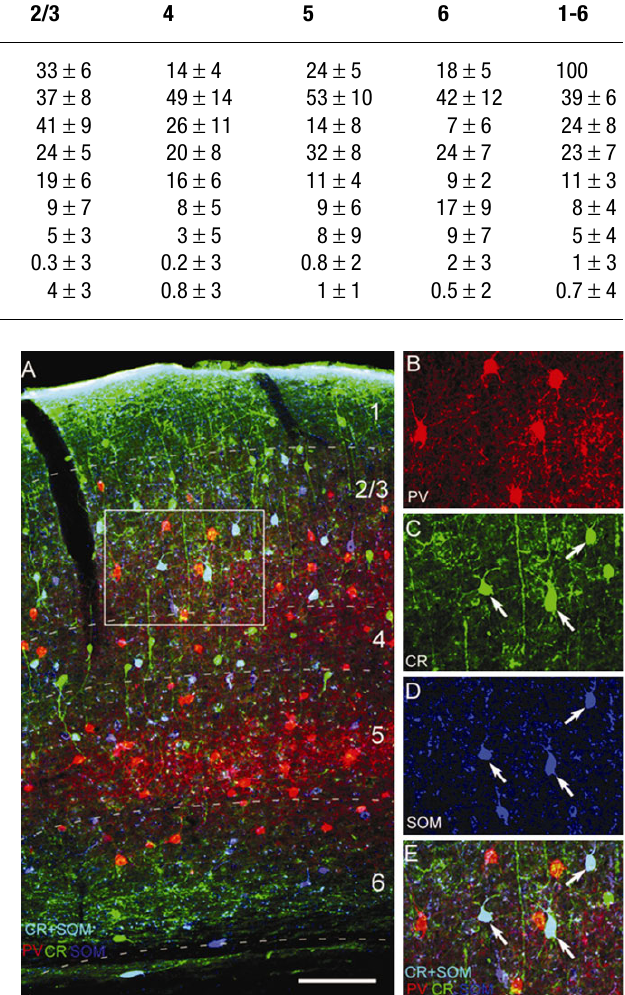
Figure 3. Triple immunolabeling with antibodies against PV, CR and SOM in adult mouse visual cortex. (A) Expression of PV (red), CR (green) and SOM (dark blue, represents false color image of infrared fl uorescence) in coronal section through V1. Neurons that colocalize CR + SOM appear light blue. (B–E) , Magnifi ed images of boxed area in (A) showing immunolabeling of PV (B, E) , CR (C, E) , SOM (D, E) and coexpression of CR + SOM (E) . Notice that PV neurons do not express CR and SOM. Scale: 100 μ m.